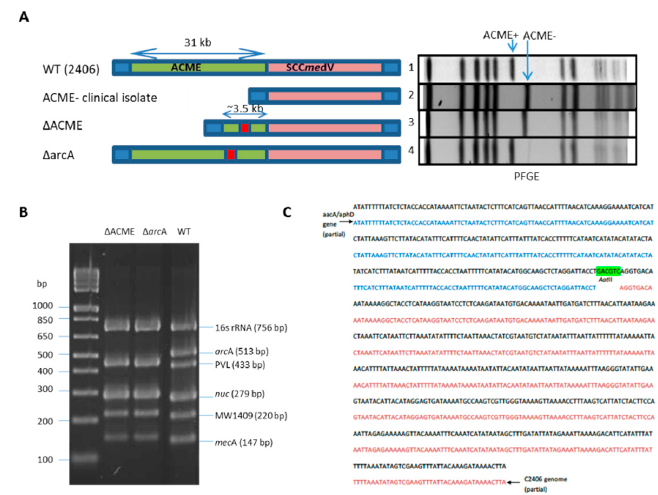
Figure 2. Construction of USA300 arc A and ACME deletion mutants. ( A ) Confirmation of ∆ ACME and ∆ arc A by PFGE. Left panel is a diagram of ACME-SCC mec regions on the bacterial chromosomes of ACME+/- USA300 clinical isolates, ∆ ACME and ∆ arc A. The right panel is the PFGE patterns of the following strains: Lane 1, ACME + USA300 clinical isolate (2406 WT); 2, ACME - USA300 clinical isolate; 3, ∆ ACME; 4, ∆ arc A. Arrows indicate the fragment containing ACME in WT, while a band shift is